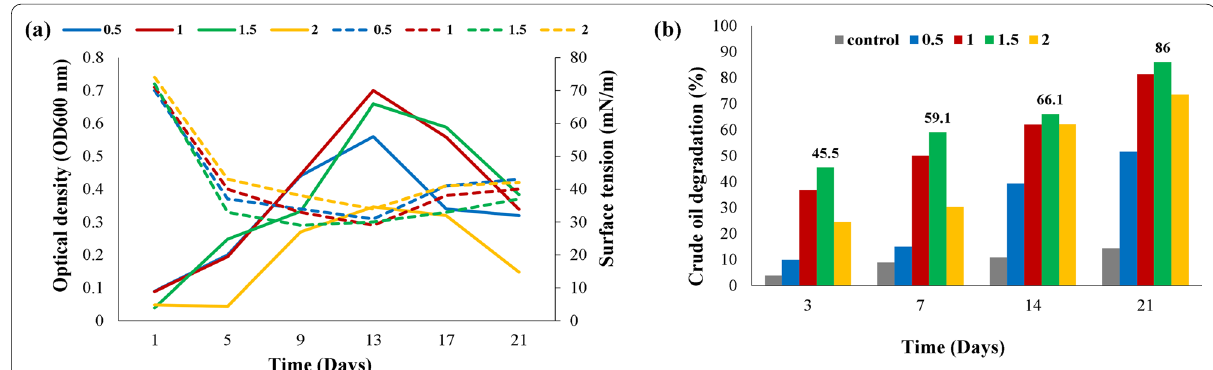
Fig. 6 The growth of a Bacillus subtilis SNW3 on crude oil and MSM with surface tension reduction values for 21 days, plane lines for OD600 and dotted lines for SFT, and b quantity of crude oil degraded (%) by Bacillus subtilis SNW3 while growing on crude oil and MSM for 21 days